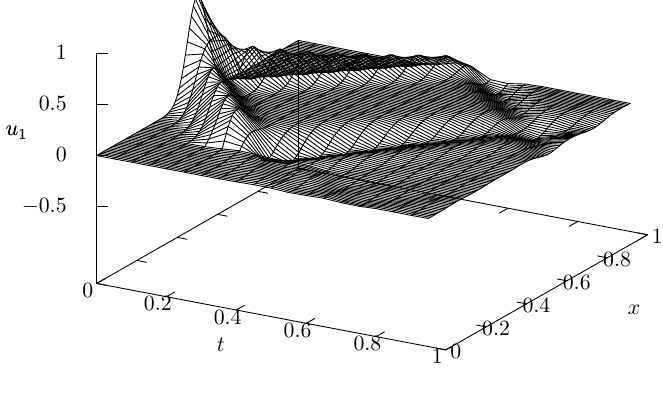
Figure 5. The numerical solution of the wave in Equation (87) with the damping terms. The waves are gradually dissipated.